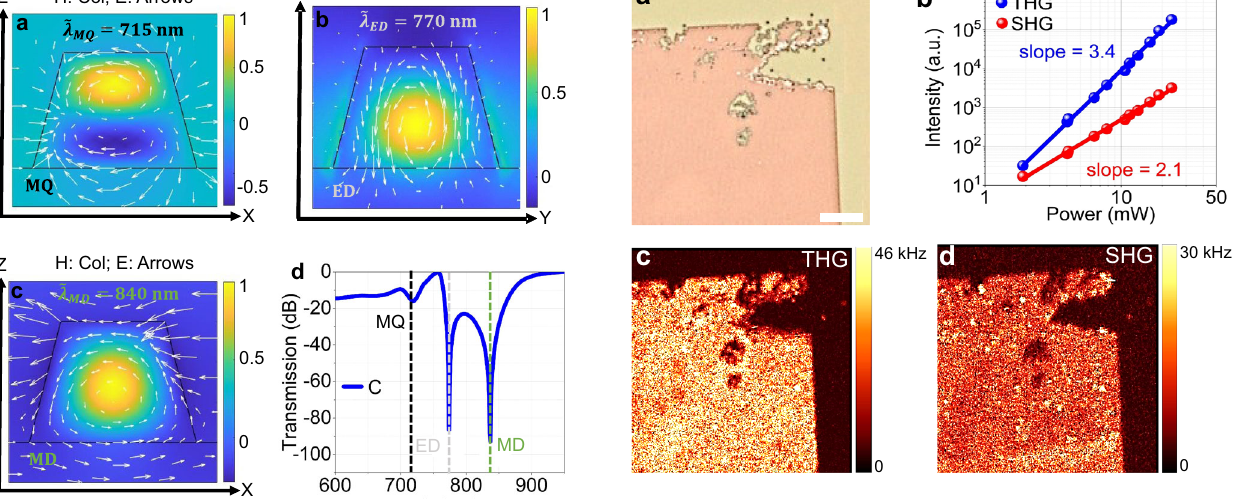
Fig. 3 Nonlinear microscopy of TMDC metasurfaces. a Optical microscopic image of MoS 2 truncated cone metasurface C, scale bar is 10 µ m. b Power dependent nonlinear second harmonic generation SHG, red colour, and third harmonic generation THG, blue colour, signals from the pump laser at 1550 nm. c , d Third- and second-order nonlinear spatial mapping of the metasurface C,